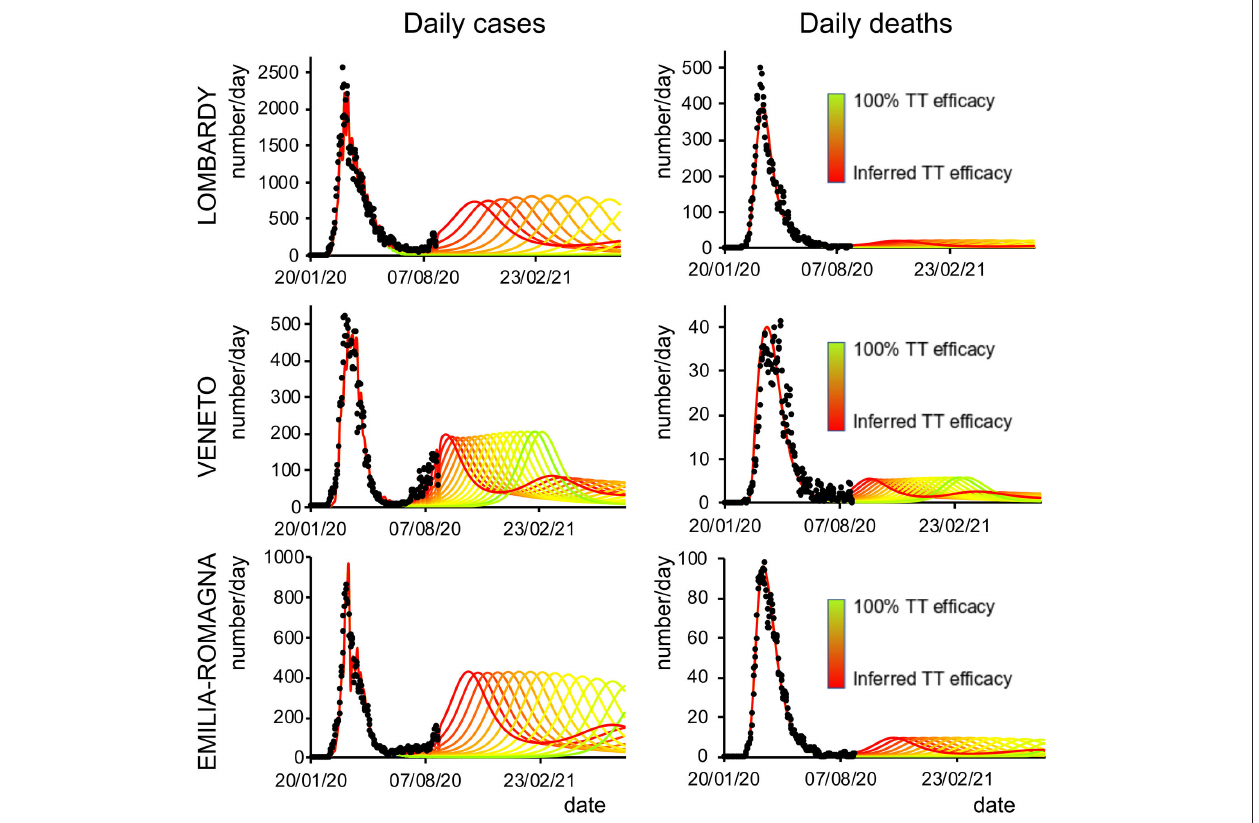
FIGURE 4 | Second-wave forecasts (Lombardy, Veneto, and Emilia-Romagna): Predicted number of daily positive cases (left) and deaths (right) under increasing levels of testing and tracking efficacy. The curves go from the value inferred by the model (red line) to 100% efficacy (green line). Black dots represent daily data averaged with a sliding window of 7